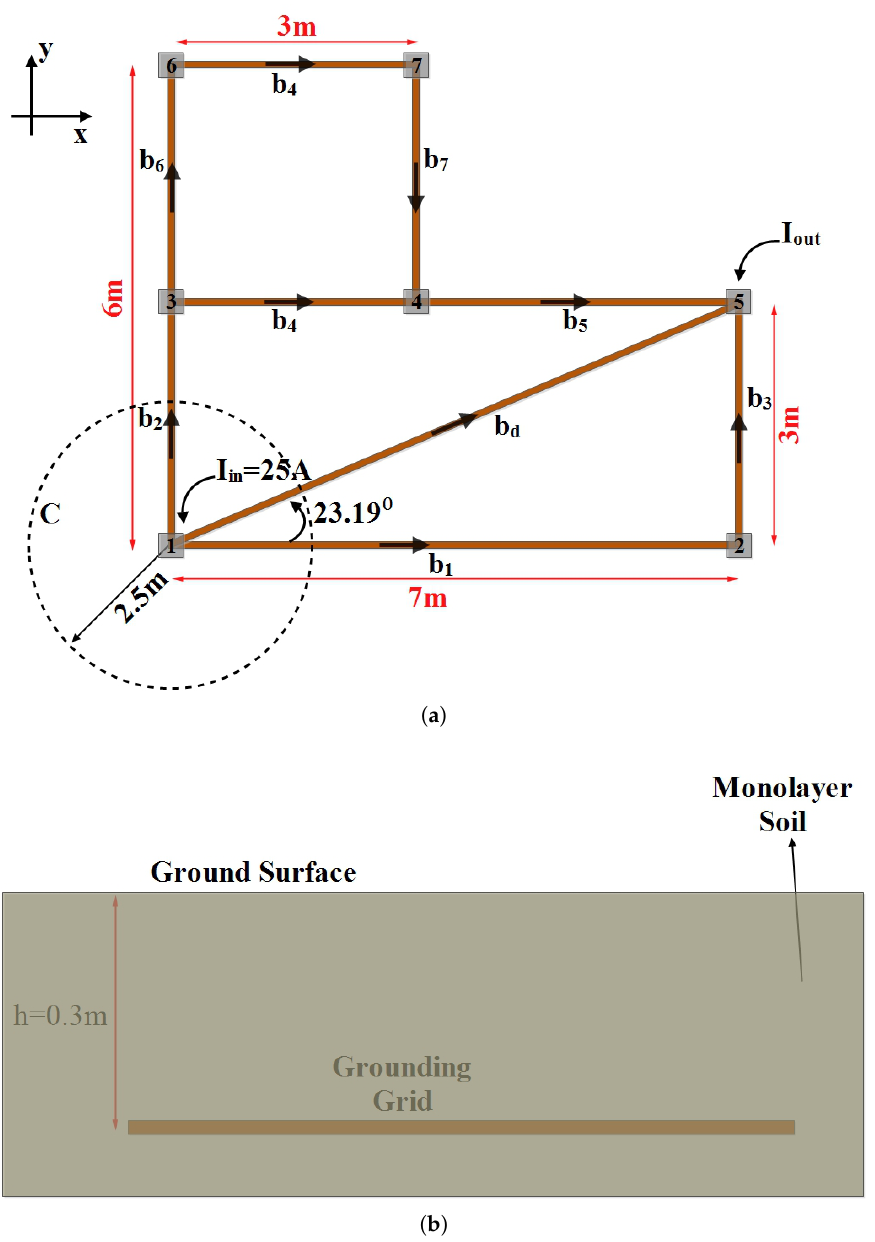
Figure 7. ( a ) Simulation model top view: Unequally spaced grounding grid having seven nodes from node 1 to 7 and branches from b 1 to b 7 made up of copper conductors of radius 0.02 m. A diagonal branch b d is also included in the mesh configuration of 7 × 3 m where minimum angular displacement of 23.19 ◦ between diagonal branch b d and a normal branch b 1 is encountered. 25A DC current flows into node 1 and returns at node 5 with current distribution as shown. Magnetic flux density is measured along the circle C whose radius is 2.5 m. ( b ) Simulation model side view: Grounding grid is buried at depth 0.3 m below the earth surface in a monolayer